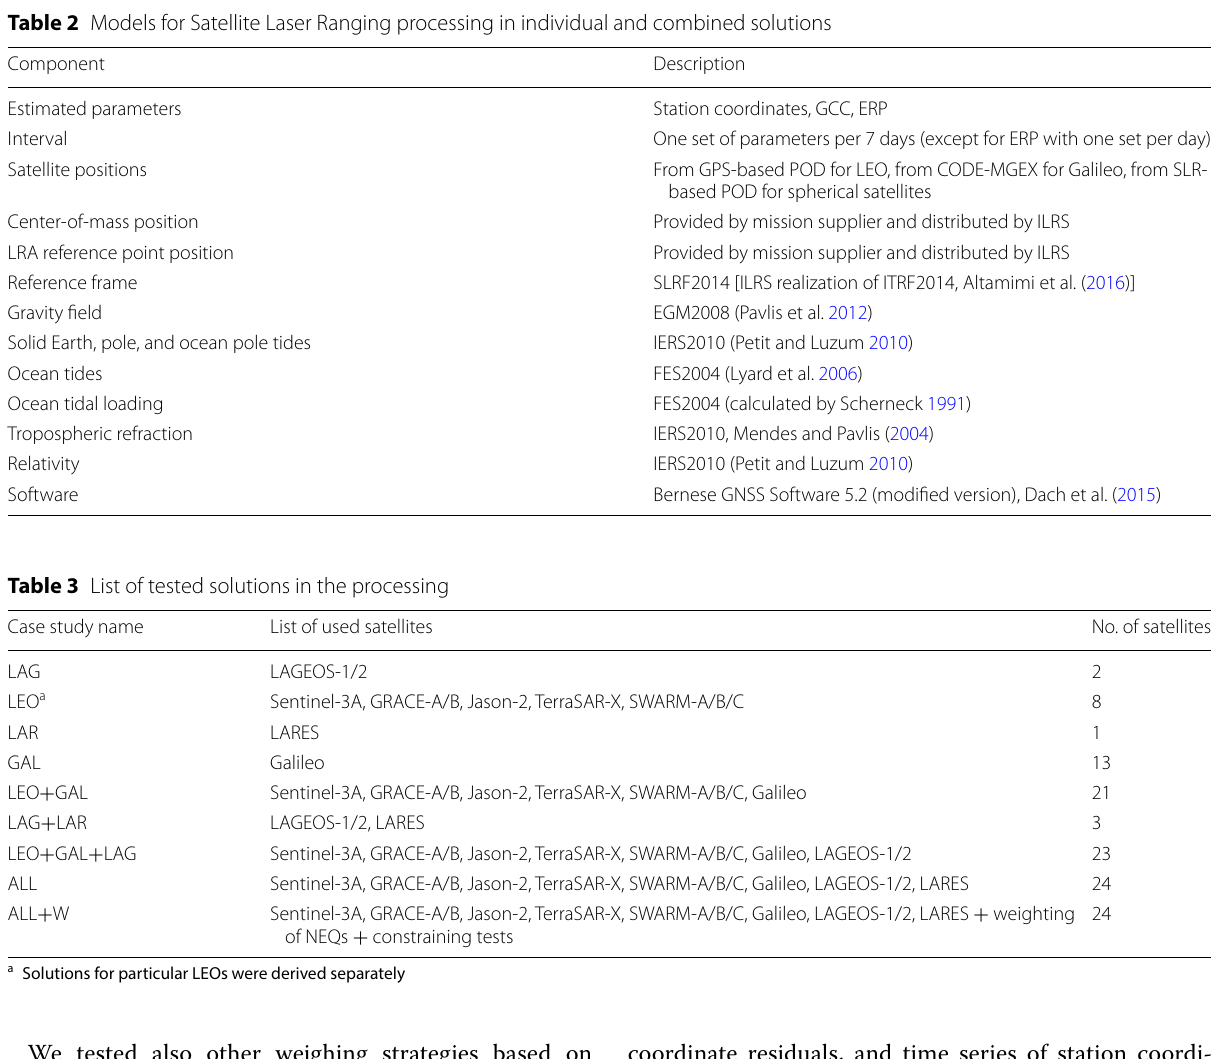
Table 2 Models for Satellite Laser Ranging processing in individual and combined solutions